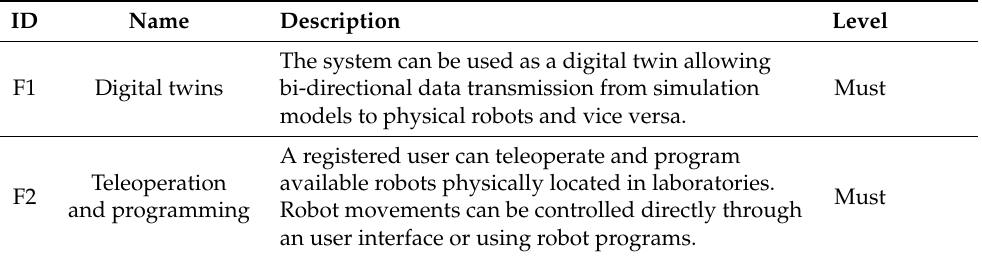
Table 1. Functional